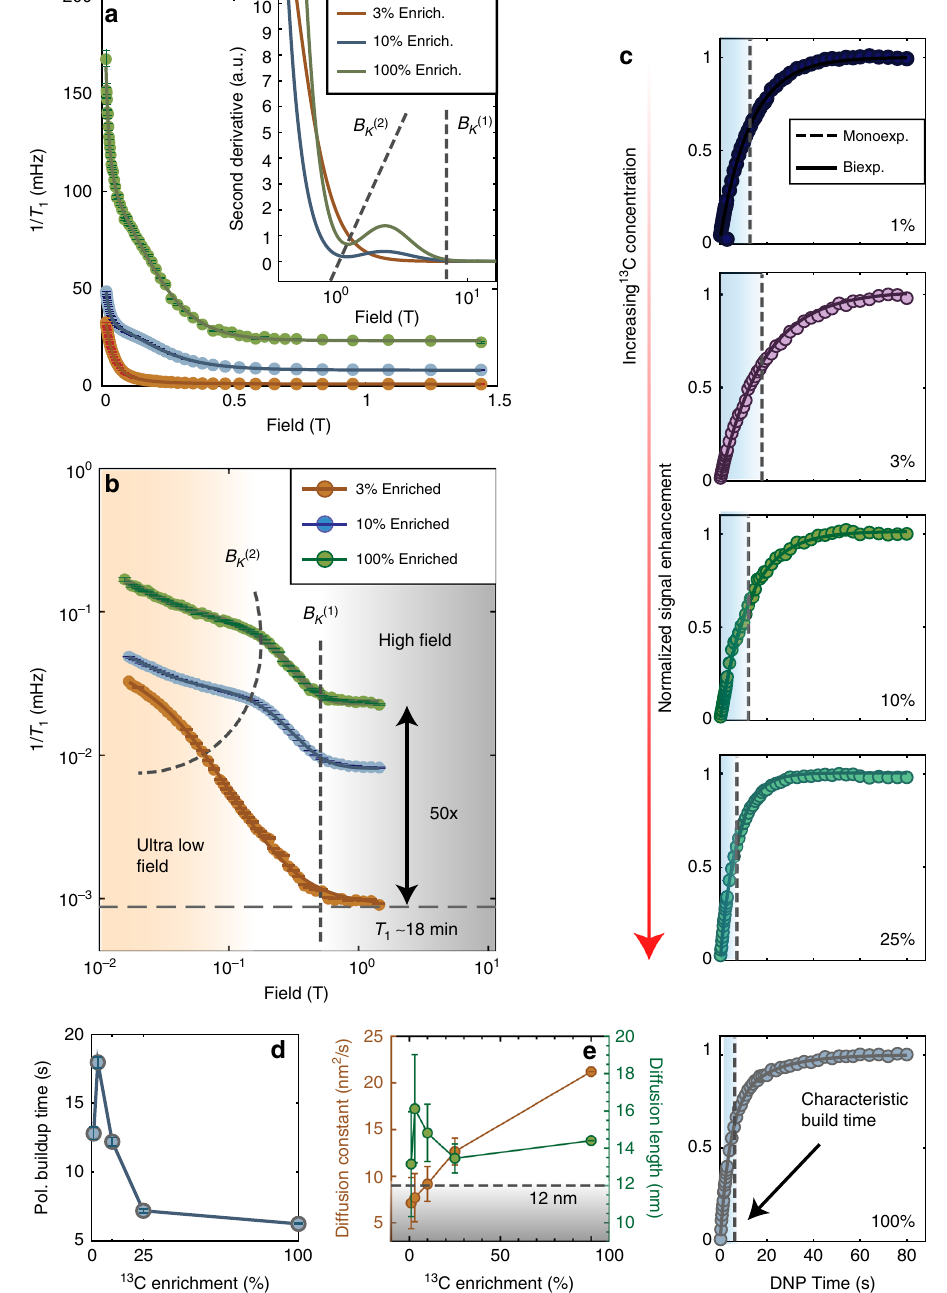
Fig. 5 Variation with 13 C enrichment. Experiments are performed on single crystal samples placed so that all the NV center orientations are identical at = 36 mT. a Relaxation rates on linear and ( b ) logarithmic fi eld scale for Samples 5 through 7 with 13 C concentrations of 3 % , 10 % , and 100 % , 54.7 (cid:4) to B pol respectively, making evident an increase in relaxation rate with increasing 13 C enrichment at low and high fi elds. Solid lines are Tsallian fi ts for each sample. Error bars obtained from con fi dence intervals of exponential decay curves for the 10 % and 100 % samples, whereas for the 3 % sample the error bars emerge from the accelerated data strategy outlined in Supplementary Fig. 4. Characteristic knee- fi eld B ð 1 Þ K (dashed vertical line) at moderate fi elds is independent of enrichment, evident in the inset. Knee fi eld at ultralow fi elds B ð 2 Þ K is qualitatively indicated by the dashed line that serves as a guide to the eye. Inset: Second derivative of the fi tted lines, showing the knee fi elds at the zero-crossings. c DNP polarization buildup curves also re fl ect differences in the nuclear spin lifetimes, displaying saturation at much shorter times upon increasing enrichment. DNP in all curves are performed at 36 mT sweeping the entire m s ¼ þ 1 manifold. d Polarization buildup times extracted from the data showing that faster nuclear spin relaxation limits the fi nal obtained hyperpolarization enhancements in highly enriched samples. e Spin diffusion constant and diffusion length for 13 C nuclei numerically estimated from the data as a function of lattice enrichment. Dashed line indicates the mean inter-electron distance r 12 nm between NV centers at 1 ppm concentration, NV h i (cid:5) indicating that spin diffusion can homogeneously spread polarization in the lattice almost independent of 13 C